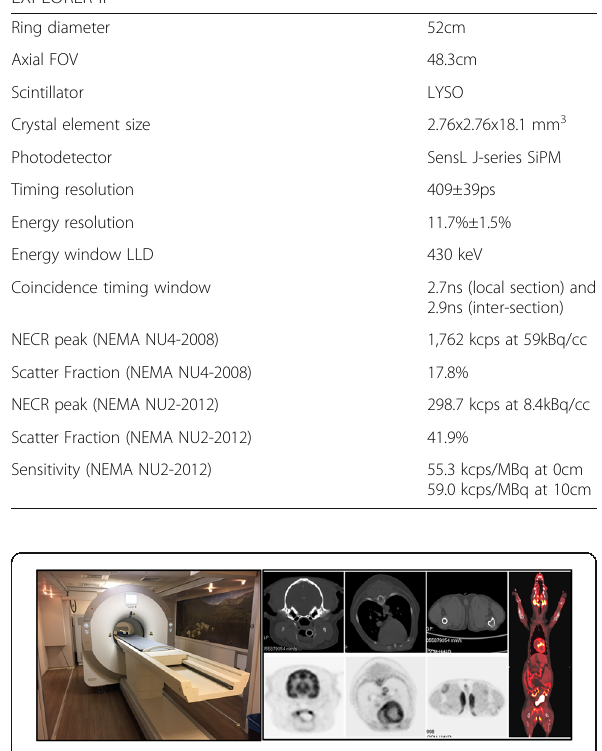
Fig. 1 (abstract A9). Mini-EXPLORER II. Left: As installed in UC Davis. Right: Images of the first canine